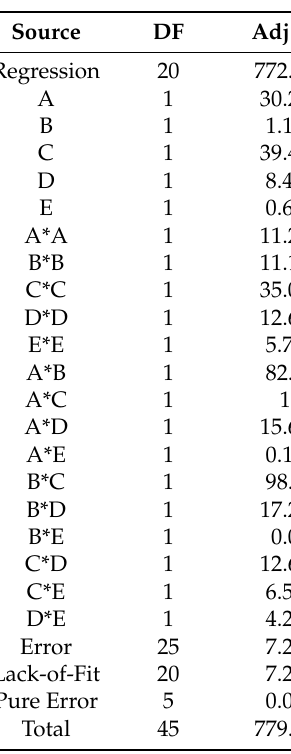
Table 7. ANOVA for ultimate tensile strength of ABS